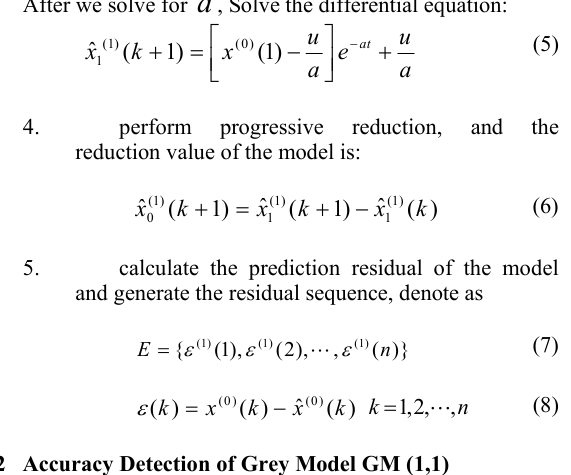
The accuracy of grey model GM (1,1) was tested using post- verification square difference ratio C , small error probability test P and correlation degree W . The calculation formulas of the three parameters are as follows: 1.